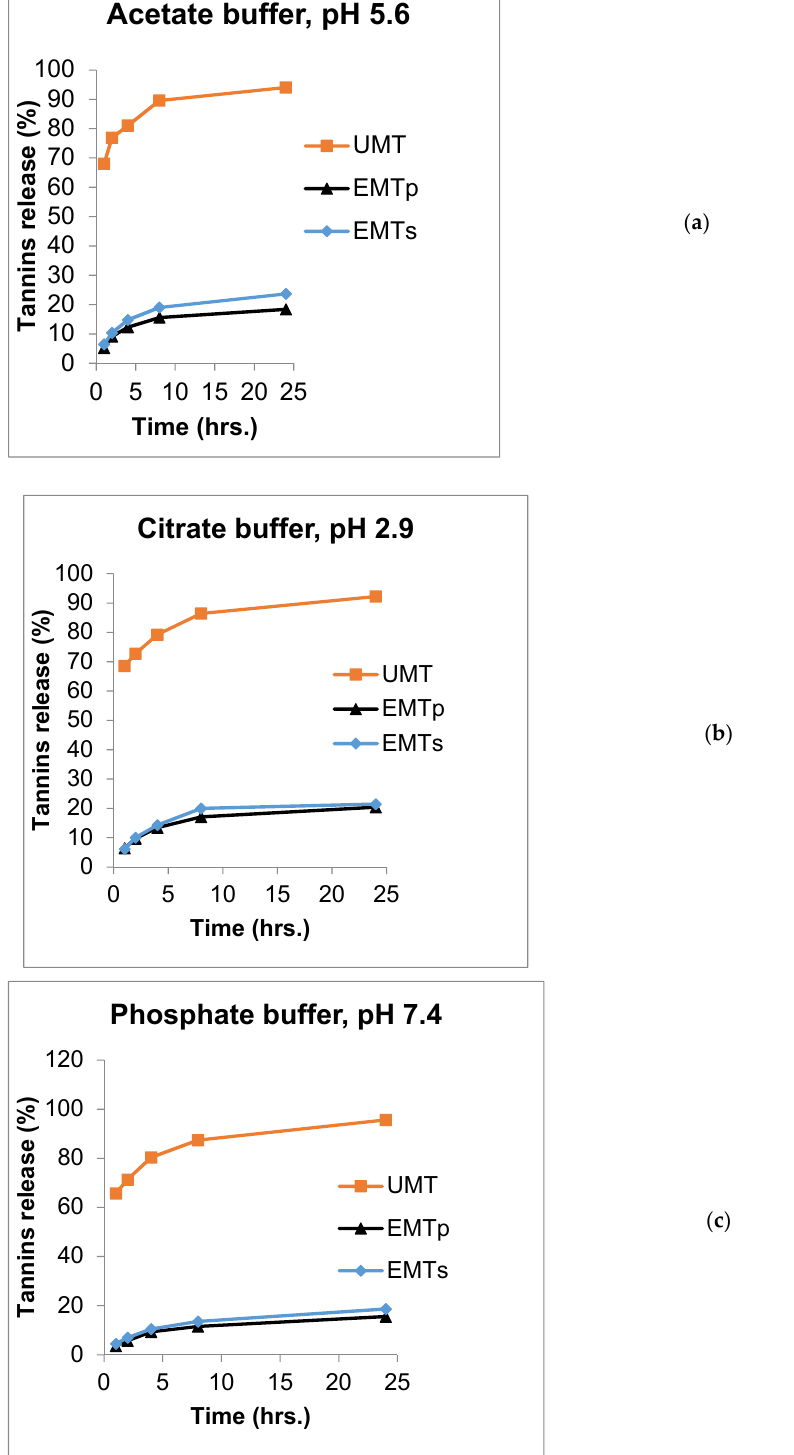
Figure 2. Release chart for UMT, EMT P and EMT S in ( a ) acetate buffer (pH 5.6), ( b ) citrate buffer (pH 2.9) and ( c ) phosphate buffer (pH 7.4).